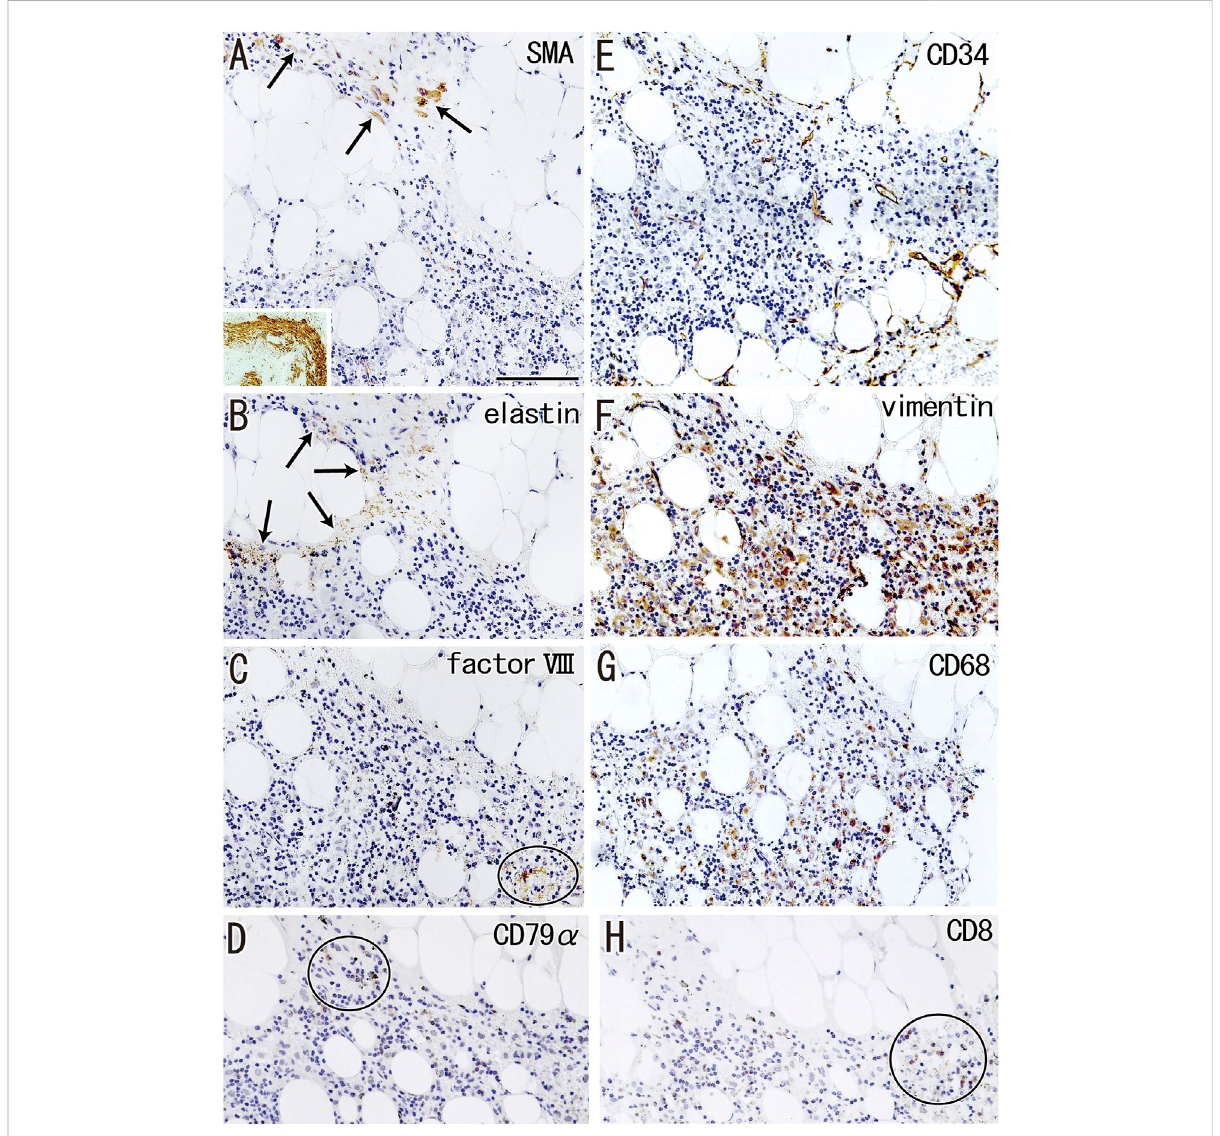
FIGURE 9 Immunohistochemistry of the fatty degeneration of the medullary sinus. Near sections of Figure 8A and higher magni fi cation views of a site indicated by a circle in Figure 8A (a hilar node removed from a 76-years-old man, non-smoker). The DAB reaction made the positive cells brown. A peninsula-likeremnantofthemedullarysinuscontainssmoothmuscleactin(SMA)-positivecells[arrowsin (A)] ,elastin-positive fi bers[arrowsin (B) ], factor VIII-positive fi bers [circle in (C) ] and CD34-positive vessels (E) . Much or less, CD68-positive macrophages (G) appear to be positive for vimentin (F) . CD79a- andCD8-positvelymphocytes[circlein (D,H) ]aresmallin numberwhen compared with abundant lymphocyte-like cellsinthe remnant medullary sinus. An insert at the lower angle of (A) shows a positive control of the present SMA antibody (artery found in the same section). All panels were prepared at the same magni fi cation [scale bar in (A) , 0.1